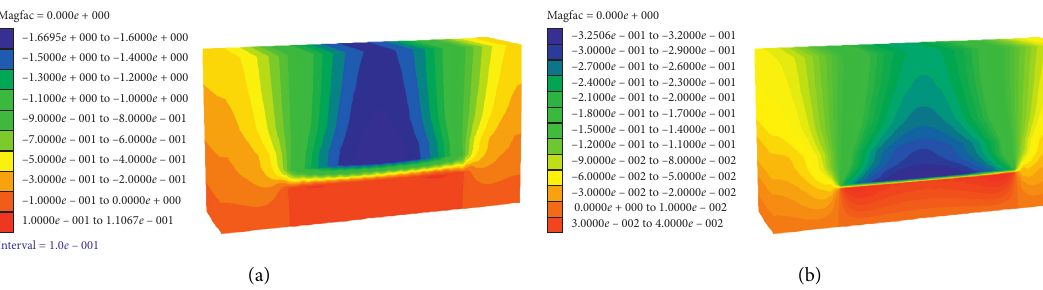
Figure 15: The vertical displacement of overburden rock. (a) Mining thickness of one layer, 3m. (b) Mining thickness of five layers, 15m.